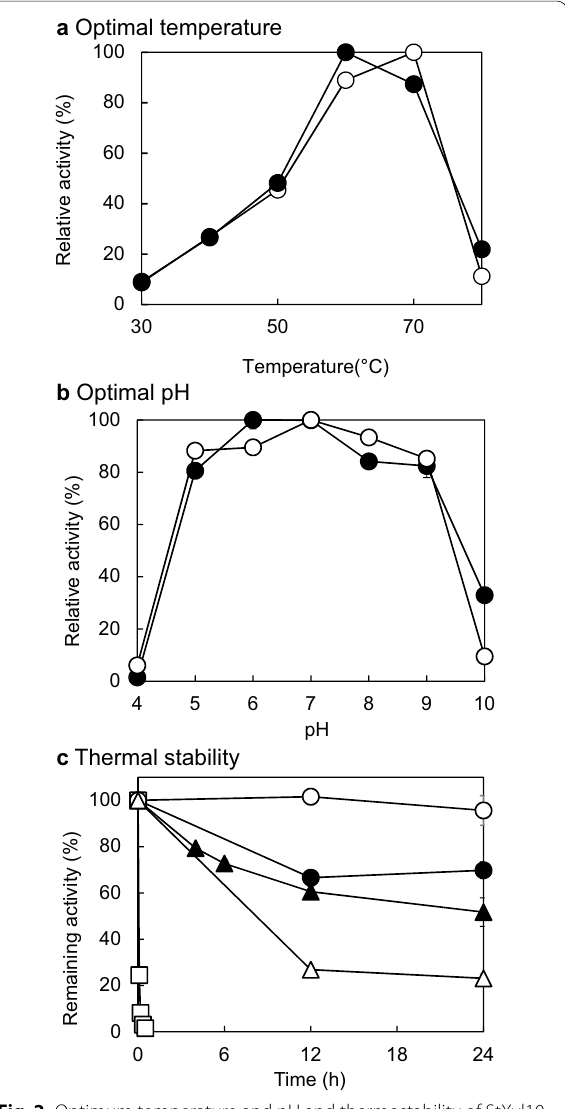
Fig. 2 Optimum temperature and pH and thermostability of StXyl10 and StXyl11. a Optimum temperatures of StXyl10 and StXyl11. The activities were measured at pH 6.5 and at 30–80 °C in a reaction mixture containing 10 mg/mL GX. White filled circle StXyl10; Black filled circle StXyl11. b Optimum pH of StXyl10 and StXyl11. The activities were measured at 65 °C in the reaction mixtures adjusted to pH 4.0–10.0. White filled circle StXyl10; Black filled circle StXyl11. c Thermal stabilities of StXyl10 and StXyl11. The remaining activities were assessed after incubation of each enzyme at 50–70 °C for up to 24 h in 10 mM sodium phosphate buffer (pH 6.5). Average values for triplicate measurements are shown with standard deviations, and error bars are within the symbols. The standard deviation within the symbols was less than 5% in all cases. White filled circle StXyl10 at 50 °C; White filled triangle StXyl10 at 60 °C; White filled square StXyl10 at 70 °C; Black filled circle StXyl11 at 50 °C; Black filled traingle StXyl11 at 60 °C. The specific activities of StXyl10 and StXyl11 for GX were 252 U/mg at 70 °C and pH 6.5 and 1392 U/mg at 60 °C and pH 6.5,